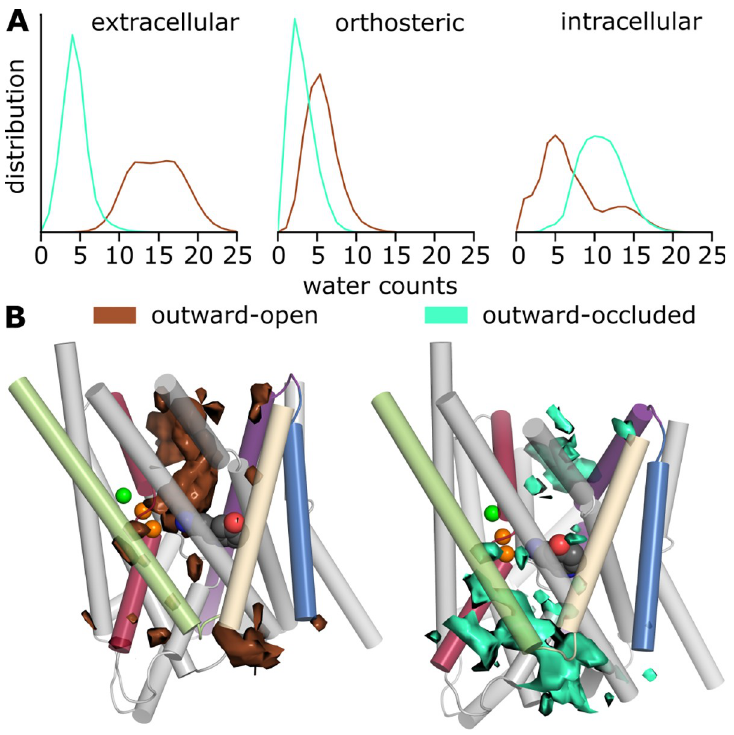
Fig 10. Hydration of the pathways in simulations of hSERT. A) The number of water molecules entering the central binding site, intra- and extracellular vestibules is shown as a normalized distribution over the total simulation time for the outward-open (brown) and outward-occluded states (green). B) Water occupancy within 20 Å of 5HT over the trajectory (1 μ s simulation time) of one representative run for each state. The protein is shown as cylinders, highlighting specific helices colored according to Fig 2 . The ligand (with C atoms in dark-gray) and sodium (orange) and chloride (green) ions are shown as